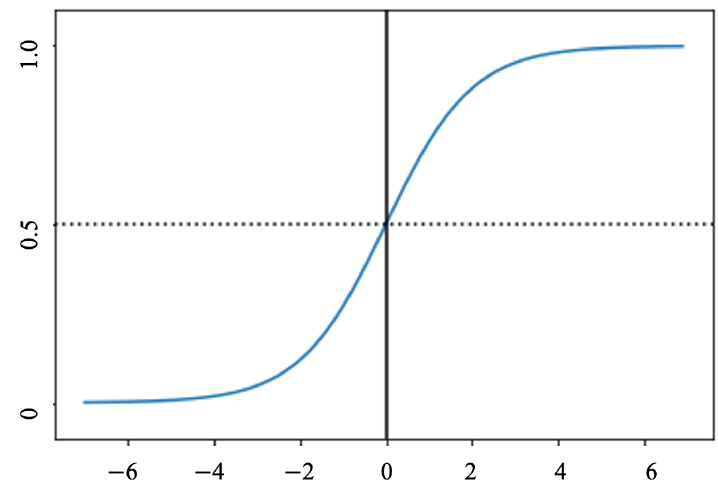
Figure 6. Sigmoid function.